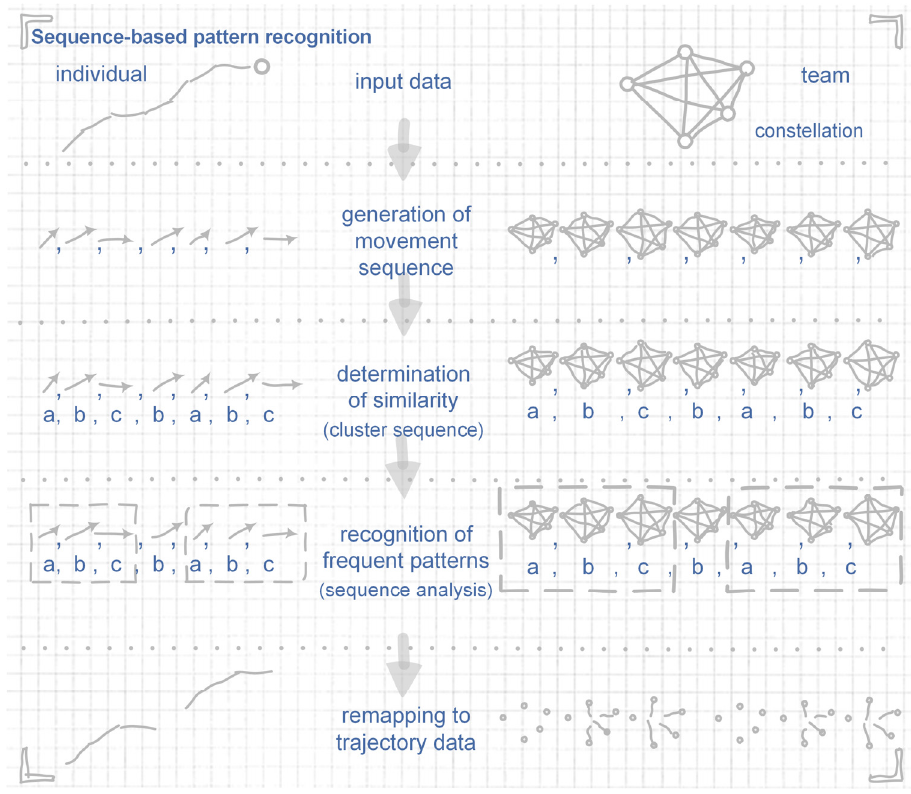
Figure 5. A detailed scheme of the recognition process for individual and team movement patterns, as it is contained as “sequence-based pattern recognition”—stage in Figure 3.